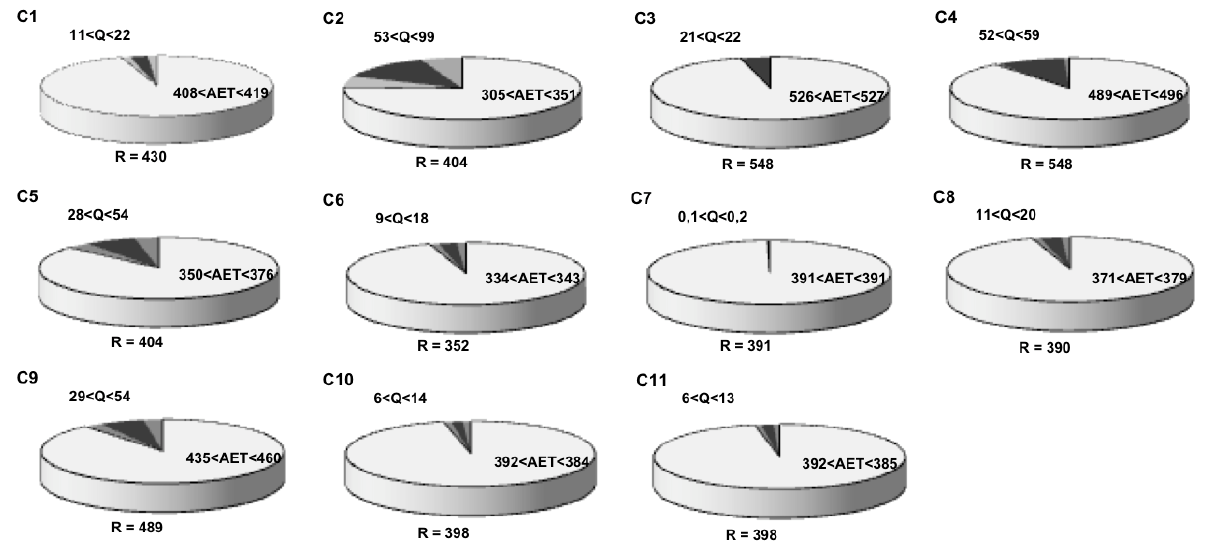
Figure 11. Water budget estimated on the eleven studied catchments for the hydrological year 2008–2009 ( R , the rainfall amount, Q , the catchment runoff and AET , the actual evapotranspiration are given as water depth in